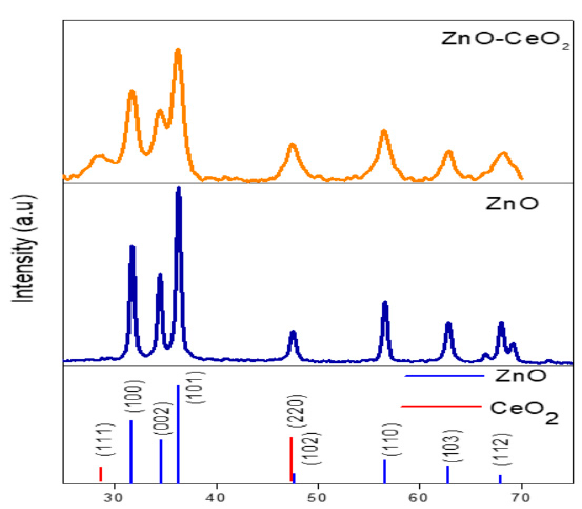
Figure 3. XRD pattern of CeO 2 -ZnO and ZnO NPs with standard JCPDS.